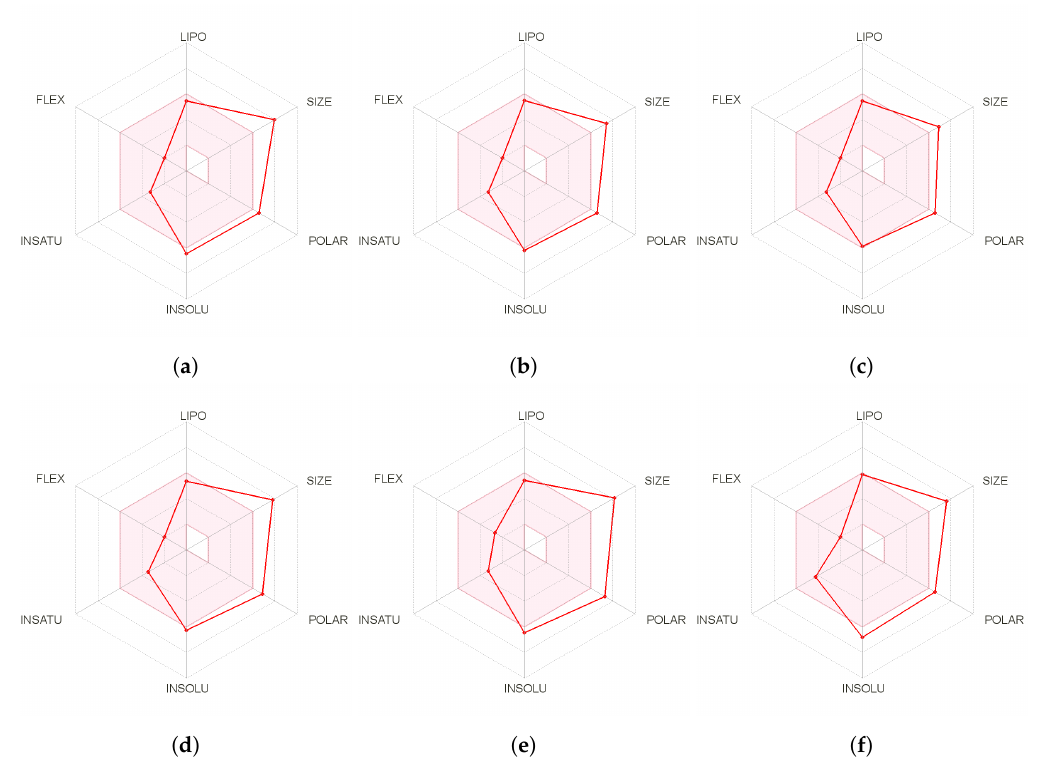
Figure 3. Bioavailability Radars of: ( a ) Seragamide A; ( b ) Seragamide B; ( c ) Seragamide C; ( d ) Seragamide D; ( e ) Seragamide E; and ( f ) Seragamide